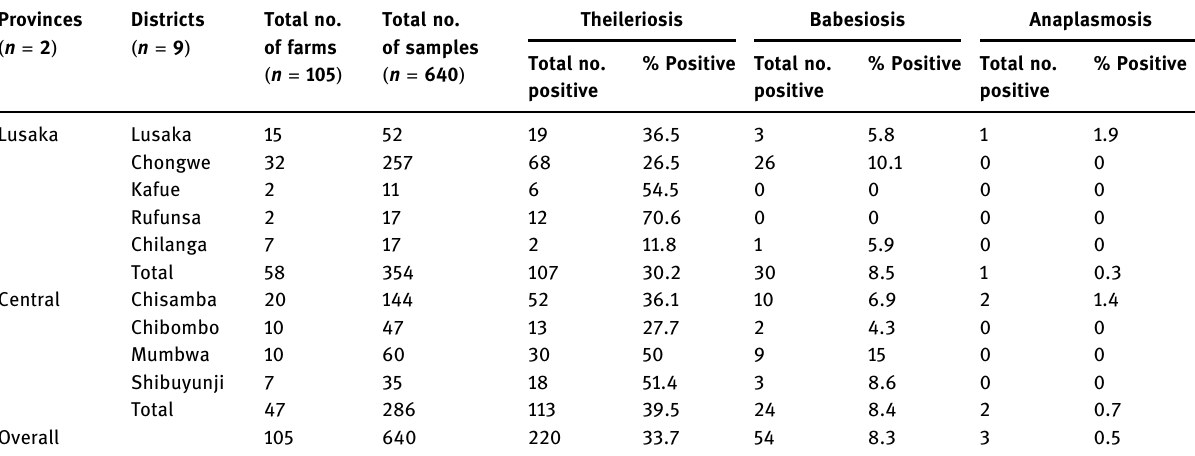
Table 1: Proportion of TBDs in Lusaka and Central provinces Provinces ( n = 2 )